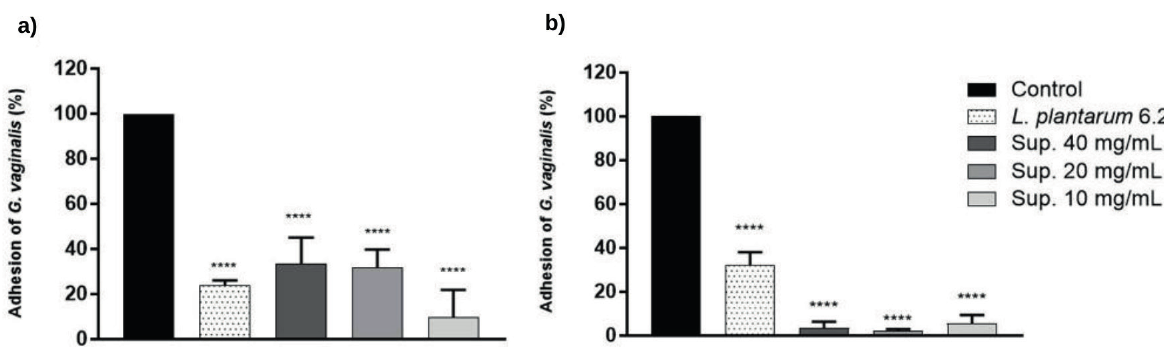
Figure 5. Exclusion (a) and displacement (b) of Gardnerella vaginalis adhering to HMVII cells promoted by treatment with Lactiplantibacillus plantarum 6.2 and its culture supernatant at different concentrations. Each value corresponds to the mean ± standard deviation of triplicates. Signifi cant differences from the control are indicated by asterisks (****p <